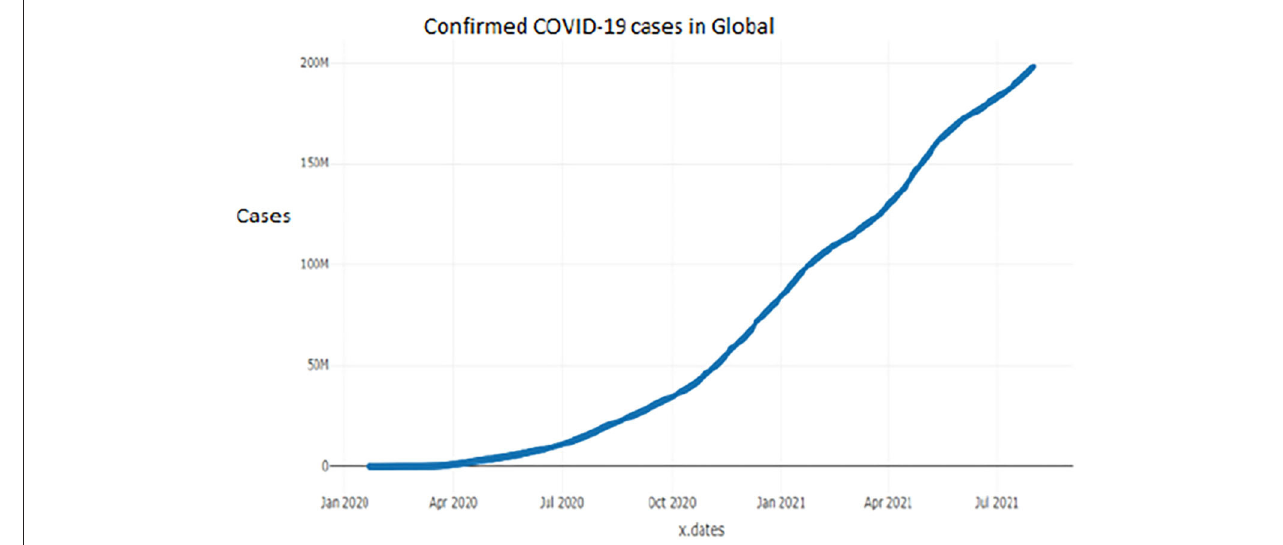
FIGURE 1 | Global cases.